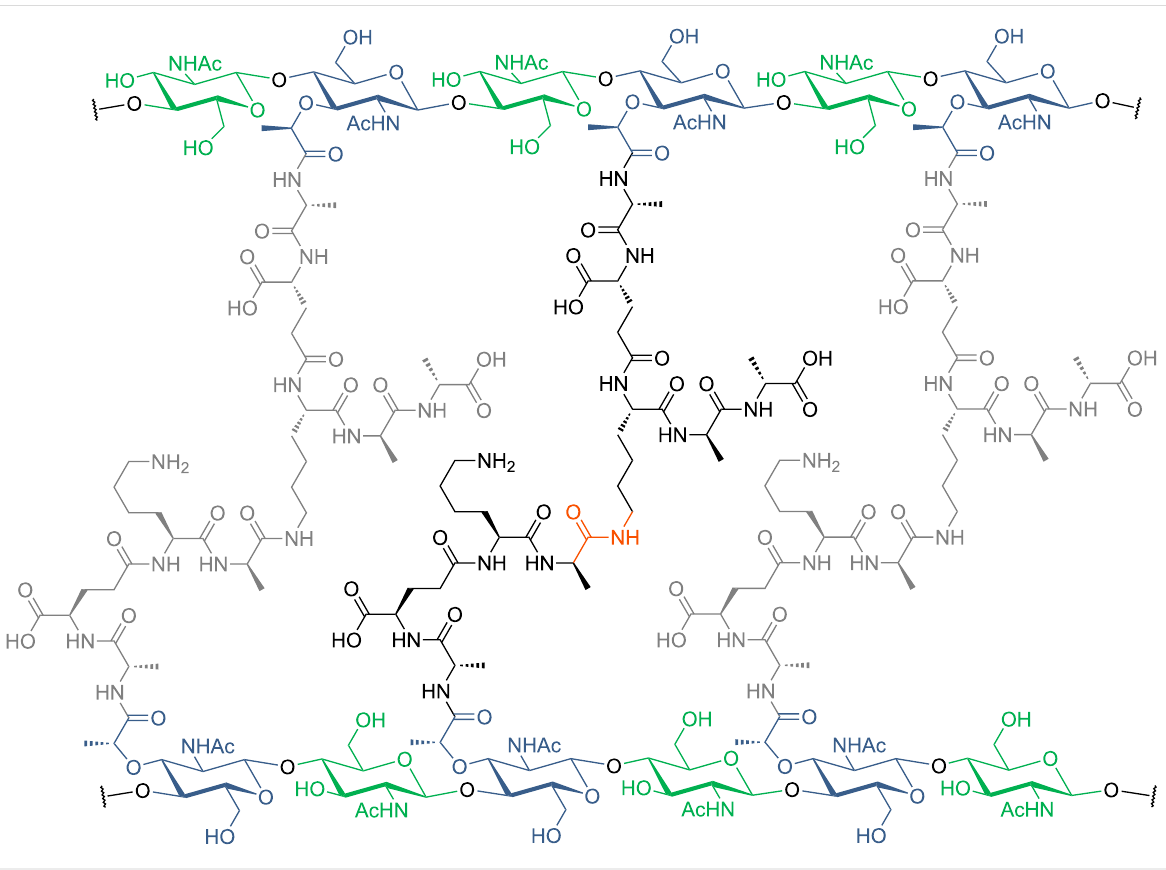
lular side of the membrane. It is speculated that there might be some kind of 'flippase' involved but this particular step is still unclear and requires further investigation [55]. On the extracel- lular side of the membrane, the building blocks are connected by transglycosylases to form long chains (Figure 4, step D) and then are cross-linked by transpeptidases (Figure 4, step E). Both enzymes are members of the family of penicillin-binding pro- teins